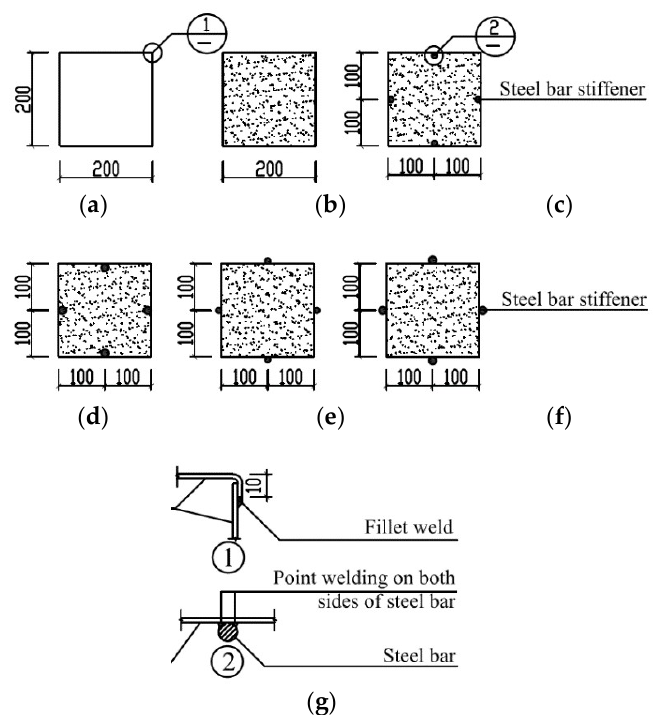
Figure 3. Section details of the specimens. ( a ) C1; ( b ) C2; ( c ) C3; ( d ) C4; ( e ) C5; ( f ) C6; ( g ) connection details.